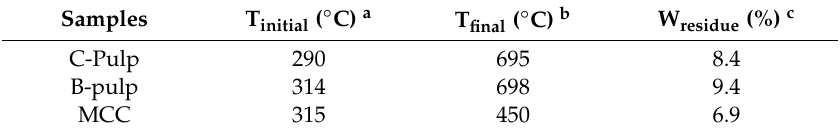
Table 2. Thermal properties of cooked pulp, bleached pulp and isolated